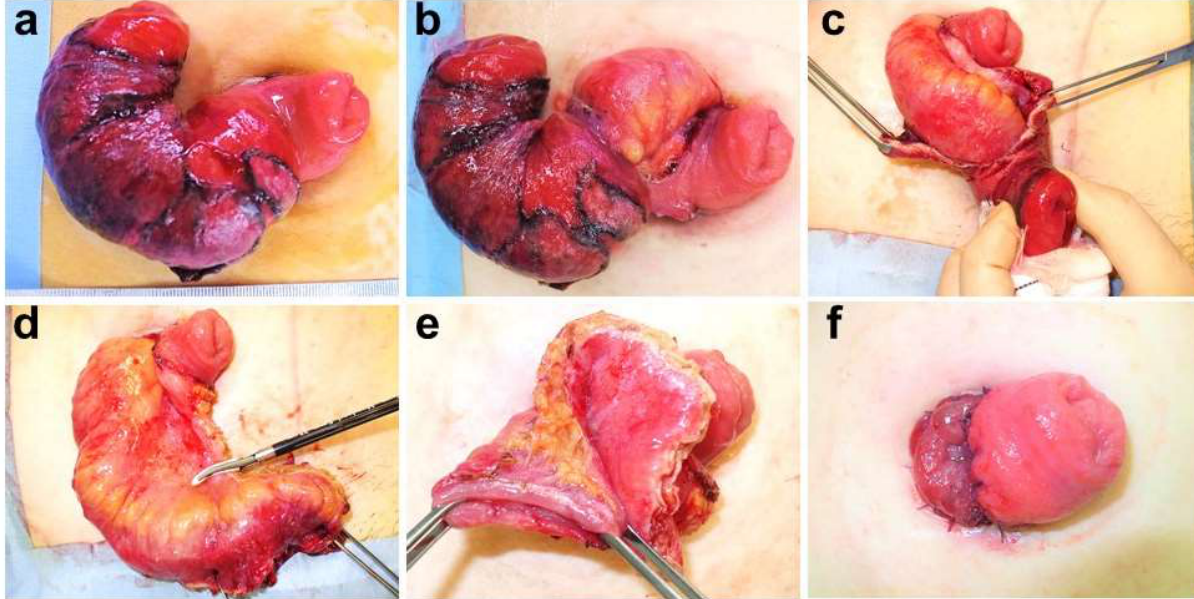
Figure 1. ( a ) Patient with a loop-type ileal artificial anus who presented with anal-side ileal prolapse; ( b ) separation between the intestinal wall and skin and peeling back of the intestine into the peritoneum; ( c ) incision in the extroverted intestinal wall of the prolapsed intestine on the antimesenteric side and reversion to an extroverted state; ( d ) separation of the mesentery of the surplus intestine; ( e ) separation of the surplus intestine and reconstruction of the artificial anus; ( f ) all-layer plication of the intestinal wall between the non-prolapsed side stomal intestines, using absorbable sutures.